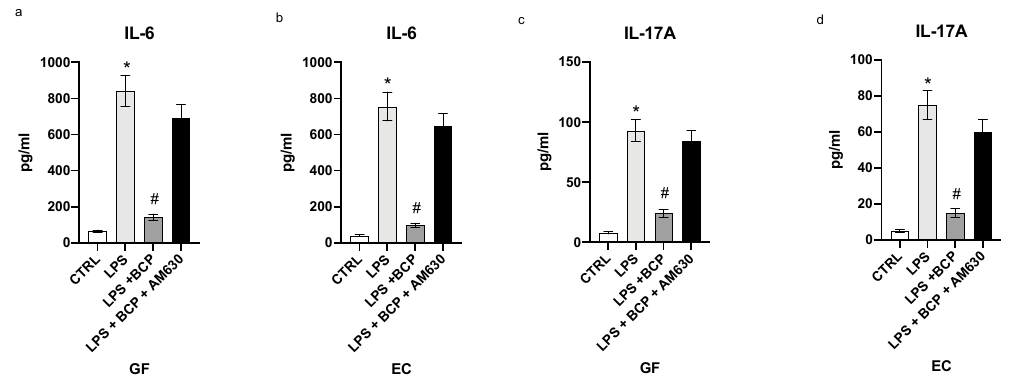
Figure 5. The graphs represent the levels of IL-6 ( a ), IL-17A ( c ) in cell supernatants from GF cells and IL-6 ( b ), IL-17A ( d ) levels in cell supernatants from EC cells. Levels of cytokines were evaluated by immunosorbent assay (ELISA). Values are expressed as the means and SD. * p < 0.0001 vs. CTRL; # p < 0.0001 vs. LPS.